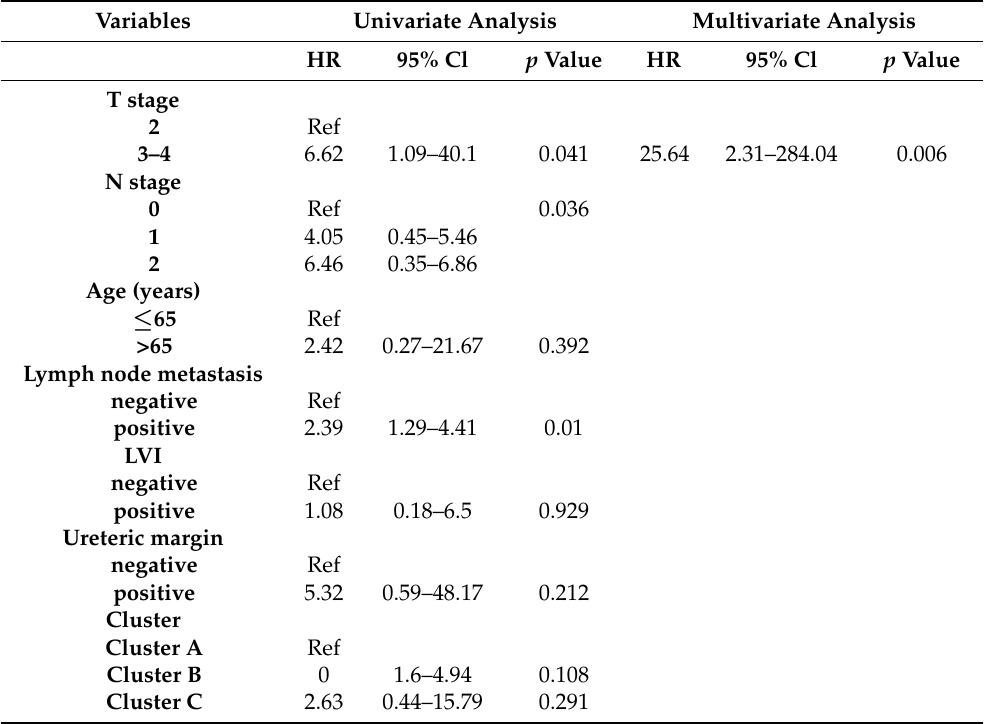
Table 3. Univariate and multivariate survival association studies by Cox hazard analysis of our MIBC